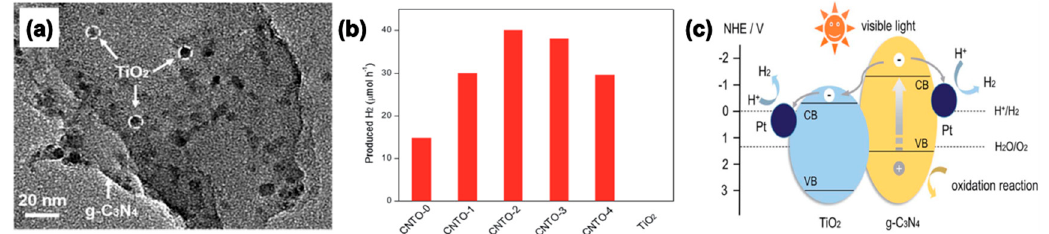
Figure 7. ( a ) A TEM image of CNTO-2, ( b ) H 2 evolution rates of the CNTO- x samples under visible light ( λ ≥ 420 nm), and ( c ) an illustration of the g-C 3 N 4 /TiO 2 heterojunction system. Reproduced with permission from [80]; copyright (2017), The Royal Society of Chemistry.